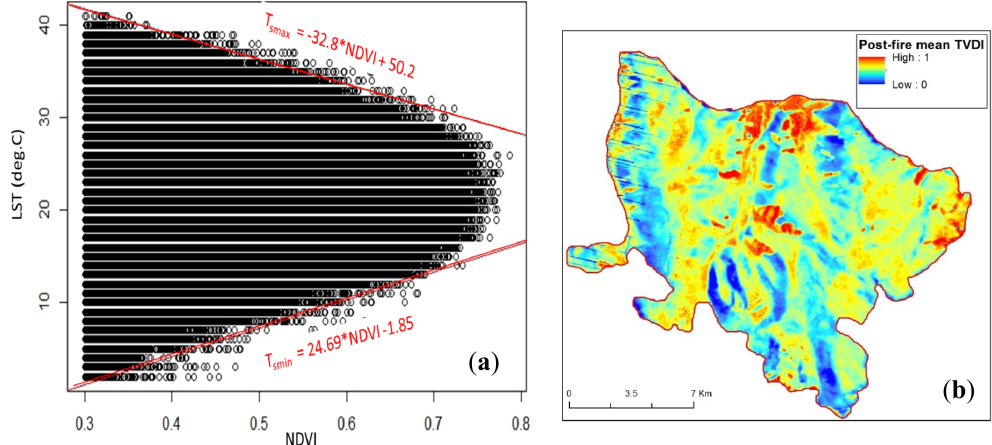
Figure 6. An example of the NDVI ‐ T s space and the determination of dry edge (T Smax = − 32.8 × NDVI + 50.2) and wet edge (T Smin = 24.69 × NDVI − 1.85) for the calculation of the TVDI in 2000 ( a ) and the mean TVDI of the post ‐ fire 18 ‐ years (1998–2014) ( b ). LST—Land Surface Temperature;